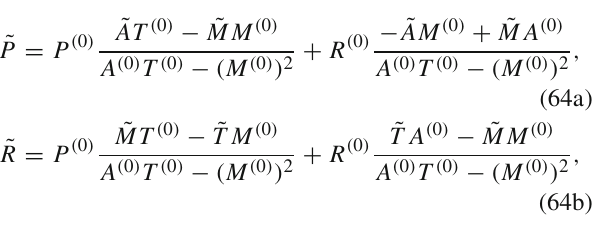
Fig. 2 Perturbative ωω → γγ amplitudes driven by the elastic A (ωω → ωω) shown as the thin line and equal on all plots for ref- erence (corresponding to a = 0 . 95). Left The coupling to the γγ sec- tor is produced only by α . Center Setting also c γ = 0 . 5 /( 16 π 2 ) but